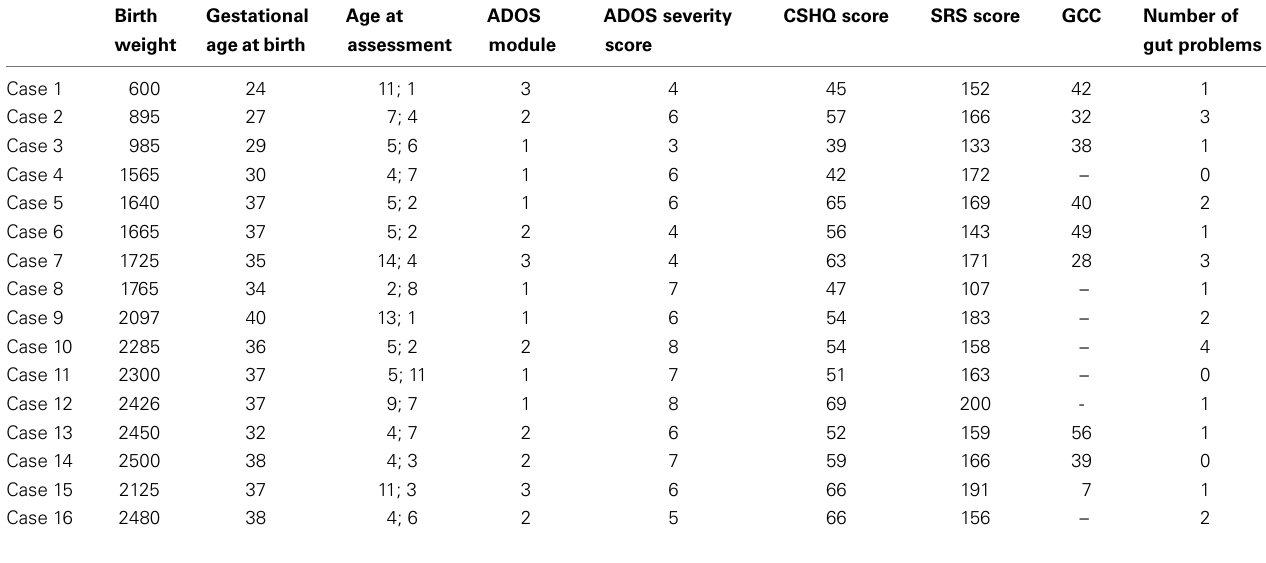
Table 4 | Study 2: offspring characteristics of the LBW case